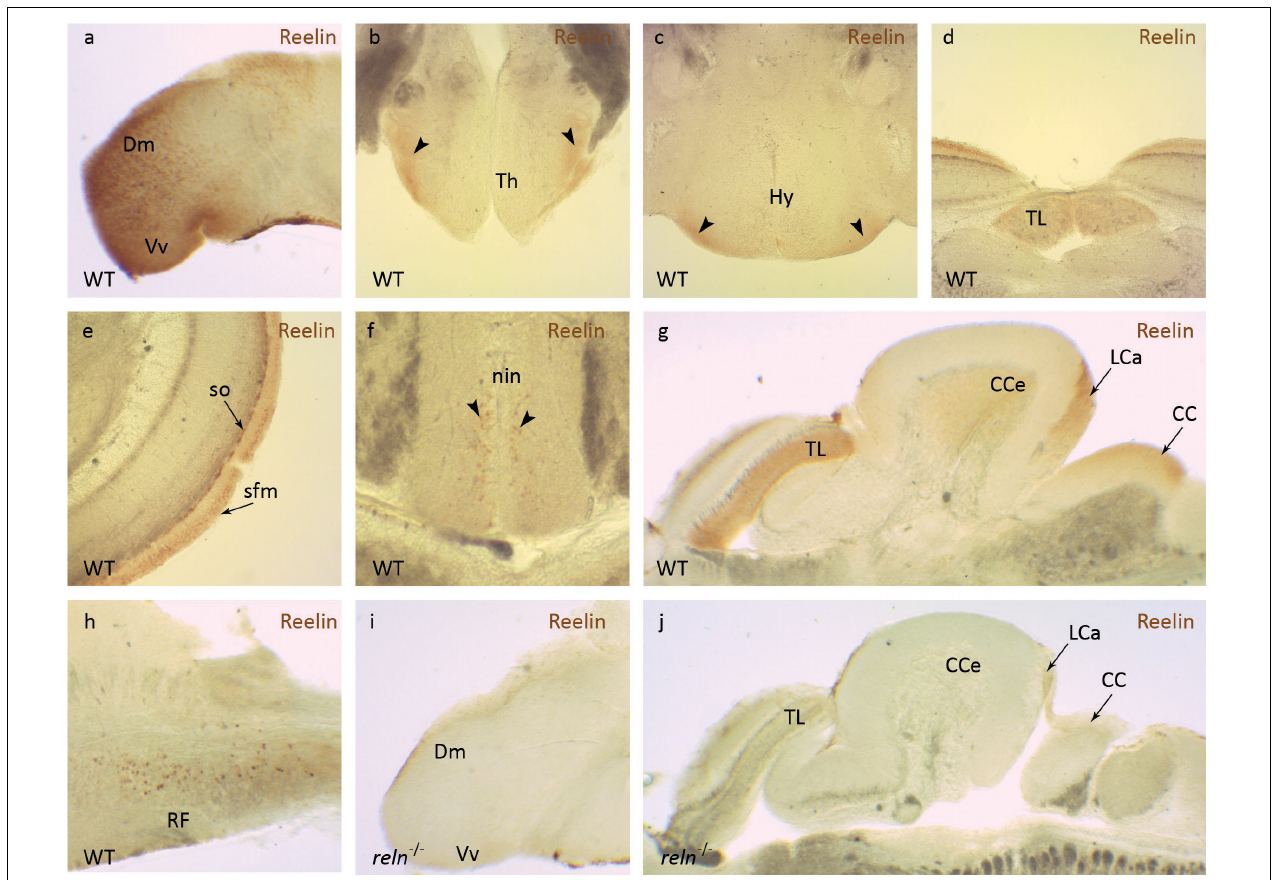
FIGURE 1 | Reelin immunohistochemistry. Anti-Reelin antibody labeling of coronal and sagittal sections of the adult zebrafish brain. In wild-type anti-Reelin antibody labeling is seen in the (a) medial part of the dorsal telencephalon (Dm) and in the ventral nucleus of the ventral telencephalon (Vm), in the (b) ventral thalamic nuclei (Th) and (c) the ventral hypothalamic nuclei (Hy). Labeling is also detected in the (d) torus longitudinalis (TL), (e) stratum fibrosum marginale (sfm) and the stratum opticum (so) of the optic tectum. (f) A few labeled cells are observed in the interpeduncular nucleus (nin). In the hindbrain, Reelin protein localizes to the (g) corpus cerebelli (CCe), the lobus caudalis cerebelli (LCa), crista cerebellaris (CC) and (h) the intermediate and inferior part of the reticular formation (RF). (i,j) Anti-Reelin antibody labeling is not detected in the brain of reln − / − mutants. Black arrowheads show position of Reelin-positive areas in (b,c,f)